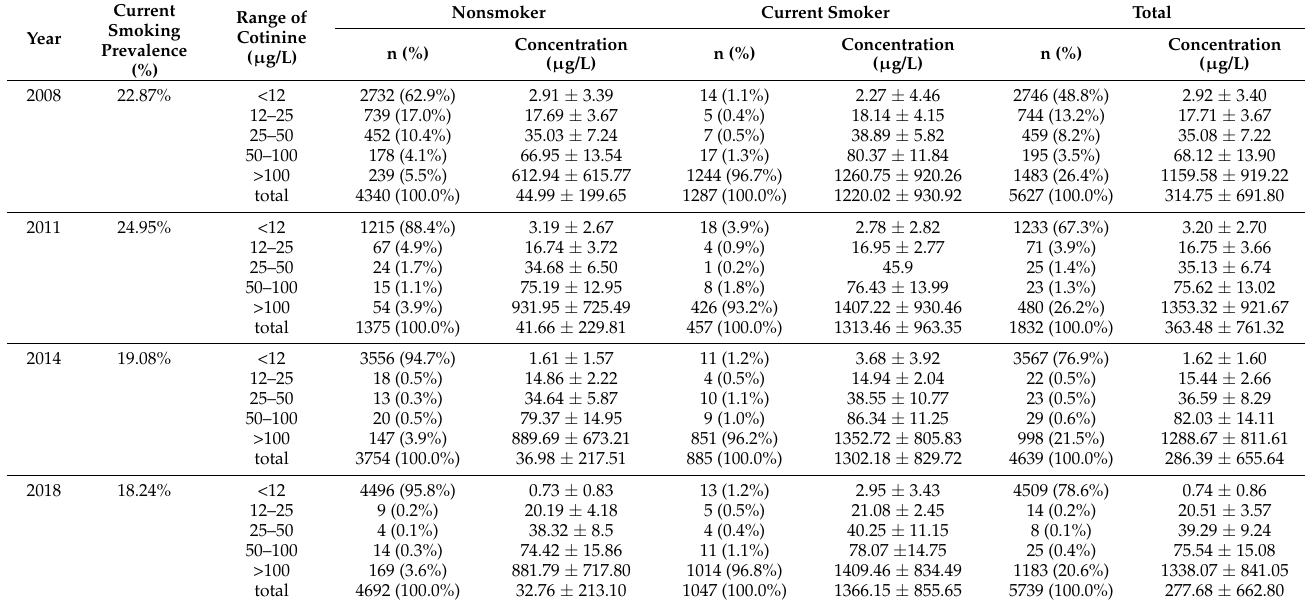
Table 7. The comparison of smoking statuses and urinary cotinine values according to various ranges of urinary